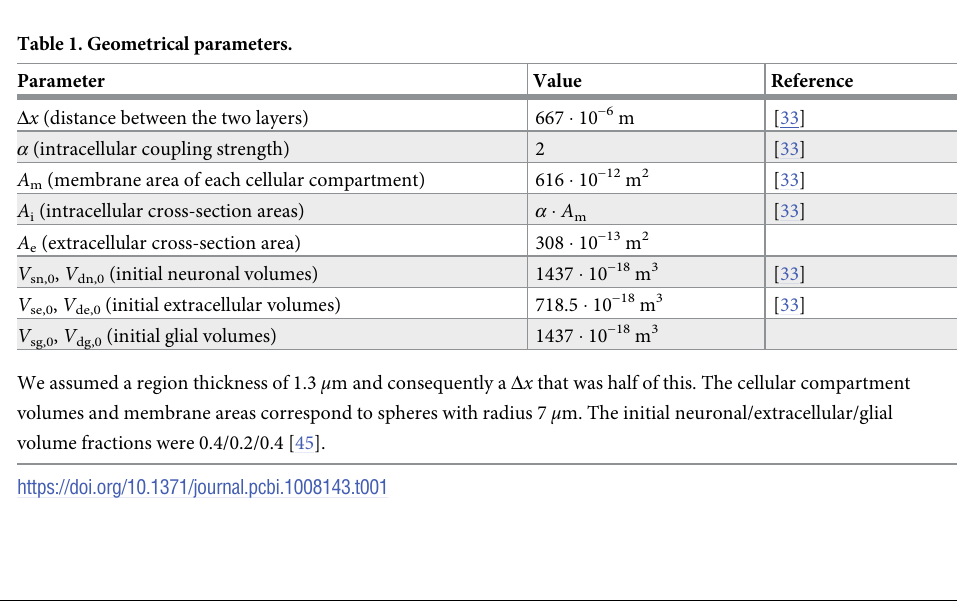
Table 1. Dynamics of ion concentrations and electric potentials in all compartments were